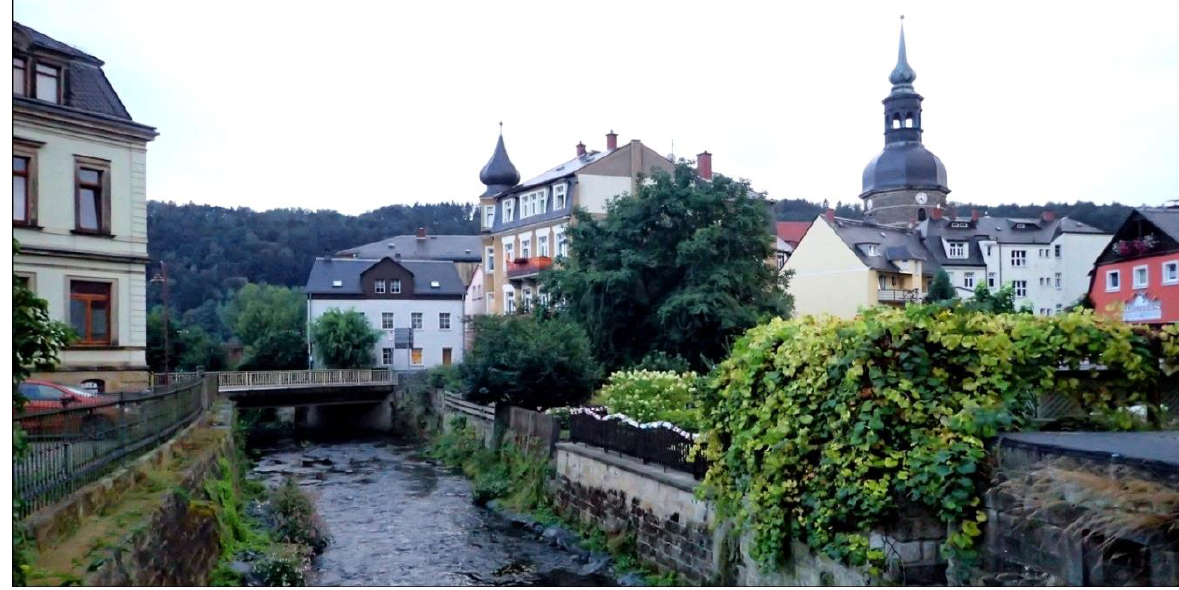
Figure 4. Panorama of downtown Bad Schandau from the side of the baths park, at the mouth of the Kirnitzsch River, a confluence of the